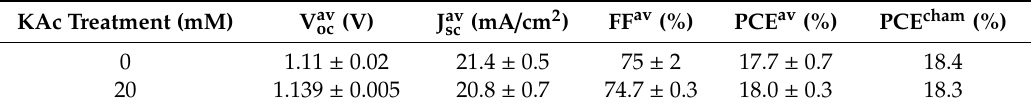
Table 3. PSCs’ photovoltaic parameters of the MAPbI 3 PSCs with KAc treatment. The J sc , V oc , FF, and PCE average values were measured in backward scanning mode. PCEs for the champion PSCs are also reported.